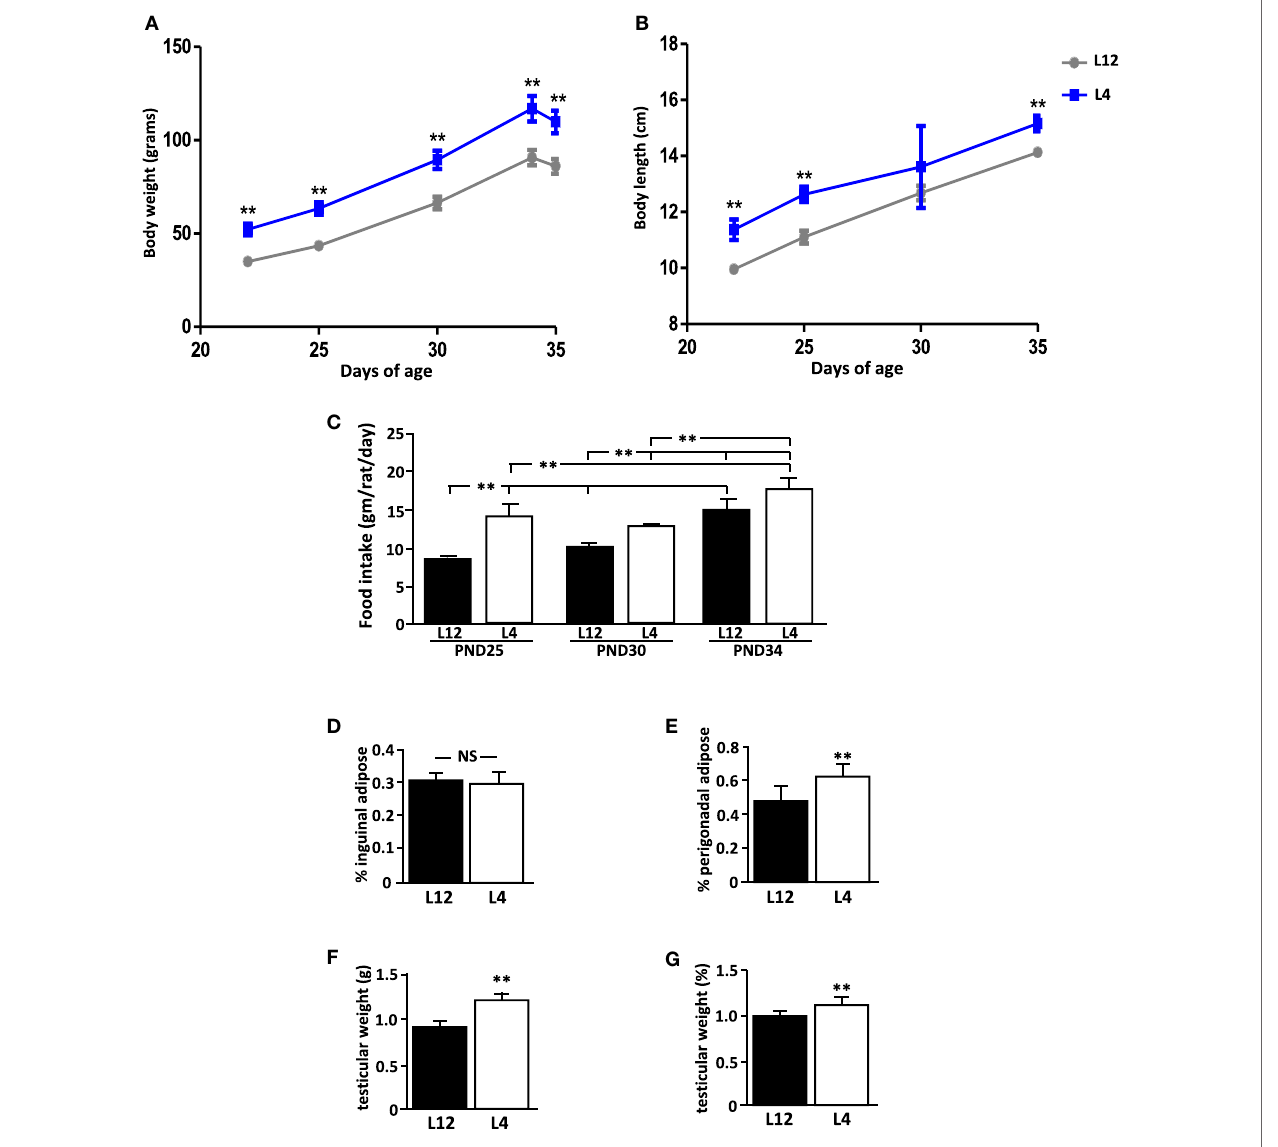
FigUre 1 | Effect of neonatal overnutrition (ON) on (a) body weight (BW), (B) body length (BL), (c) food intake, (D) inguinal adipose tissue, (e) perigonadal adipose tissue, (F) testicular weight, and (g) normalized testicular weight in peripubertal male rats raised in litters of 12 (L12) or litters of 4 pups ( n = 12). PND, postnatal day. ** p < 0.01. NS, non-significant. Results are presented as mean ±